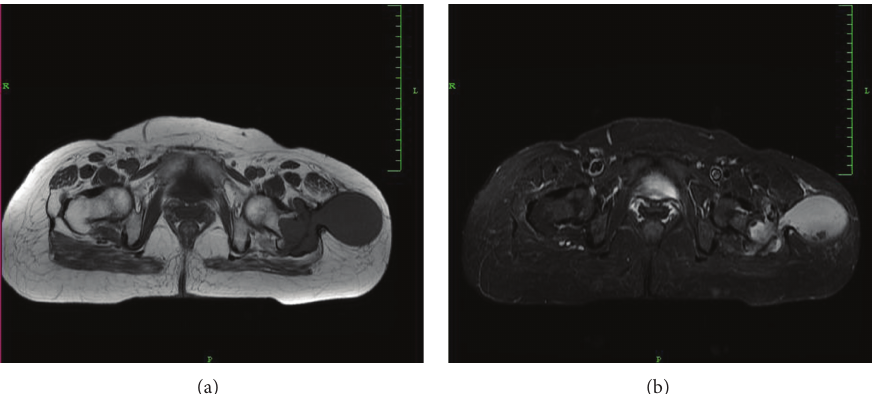
Figure 4: Axial T1- and T2-weighted MRI image of the pelvis showing the abscess extending from the left greater trochanter into the subcuta- neous tissues laterally through a small defect in the deep fascia resembling a dumb-bell-shaped abscess.